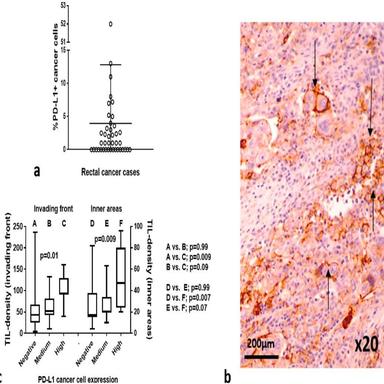
Analysis of PD-L1 expression by cancer cells: (a) Distribution of cases according to the % of PD-L1 + cancer cells (the scatter plot shows the distribution of values, 33rd percentile, and 67th percentile and median values); (b) Typical immunohistochemical image of membrane PD-L1 expression by cancer cells (black arrows); (c) Distribution of TIL-density in the three groups of PD-L1 expression status in cancer cells (Box and whiskers show the min, max, 33rd percentile and 67th percentile and median values).